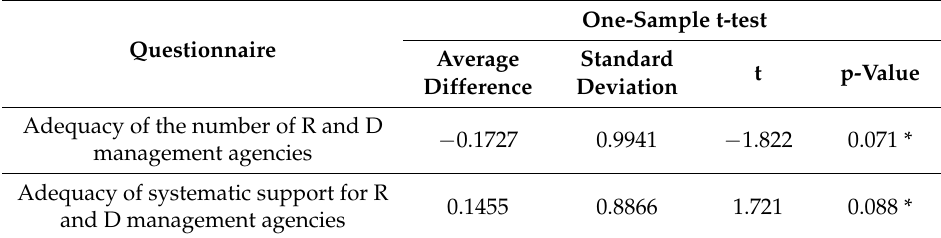
Table 3. Governance system of R and D management